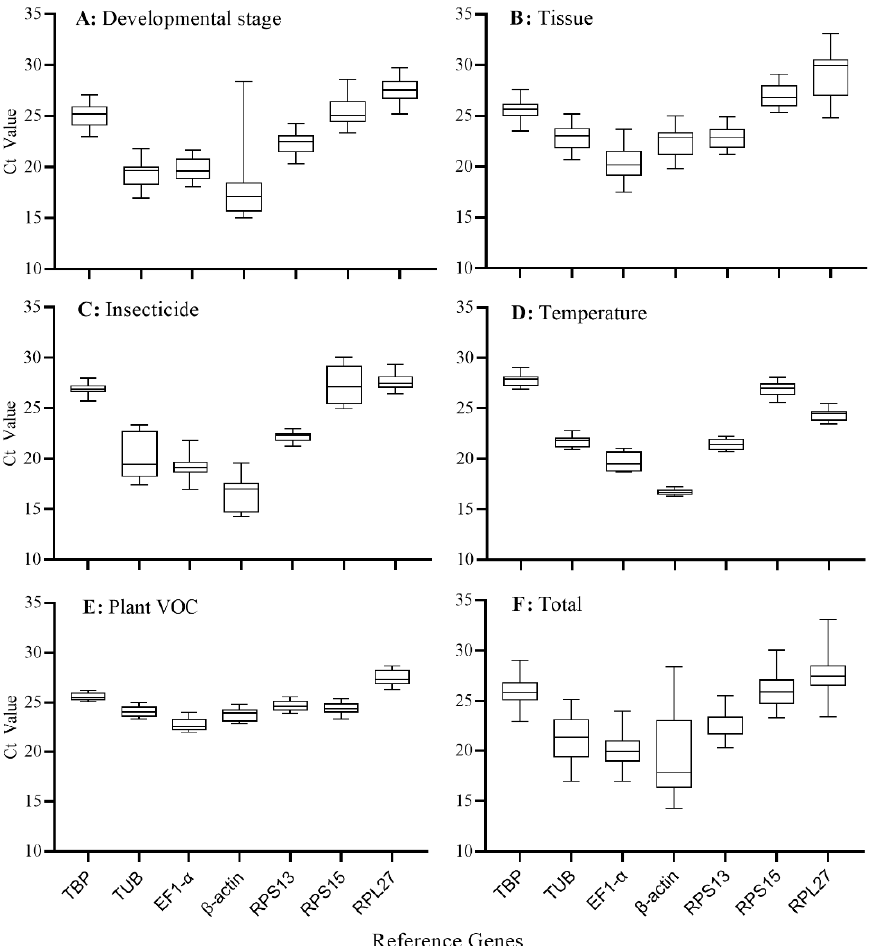
Figure 1. Expression levels of seven candidate reference genes in T. absoluta . Line across the box shows the median value, while inside the box indicates Ct values. The top and bottom whiskers represent the 25th and 75th percentages, respectively. Developmental stages ( A ), adult tissues ( B ), insecticides ( C ), temperatures ( D ), plant VOCs ( E ), and total ( F ) based on C t values of all samples exhibited in the five experimental conditions.